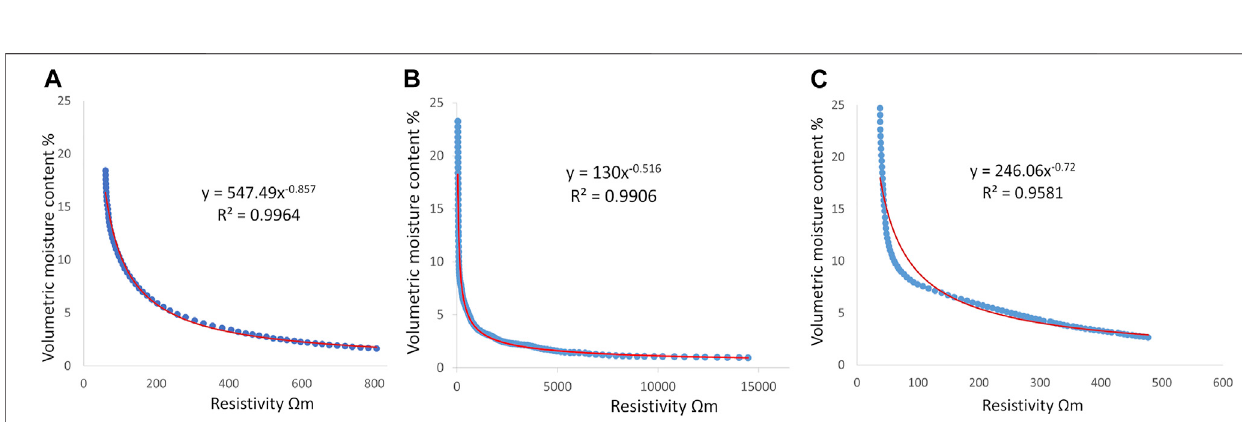
EC of 12 – 24 mS m − 1 . The lower-range inverted EC of 0 – 12 mS m − 1 in the middle of the fi eld in the dry season ( Figure 2K ) and in the top east corner in the wet season ( Figure 2N ). During the dry season ( Figure 2L ), the last depth slice of 0.8 – 1.6 m showed the west half of the fi eld with mid- range inverted EC (12 – 24 mS m − 1 ) and the east half with high- range inverted EC (24 – 36 mS m − 1 ). The last depth slice for the wet season survey ( Figure 2O ) showed high-range (24 – 36 mS m − 1 ) inverted EC except for the top east corner. The percentage difference maps from the dry to wet season survey show a relatively large change in the south- east part of the top depth slice (0 – 0.5 m; Figure 2P ). For the second depth slice (0.5 – 0.8 m; Figure 2Q ), inverted EC